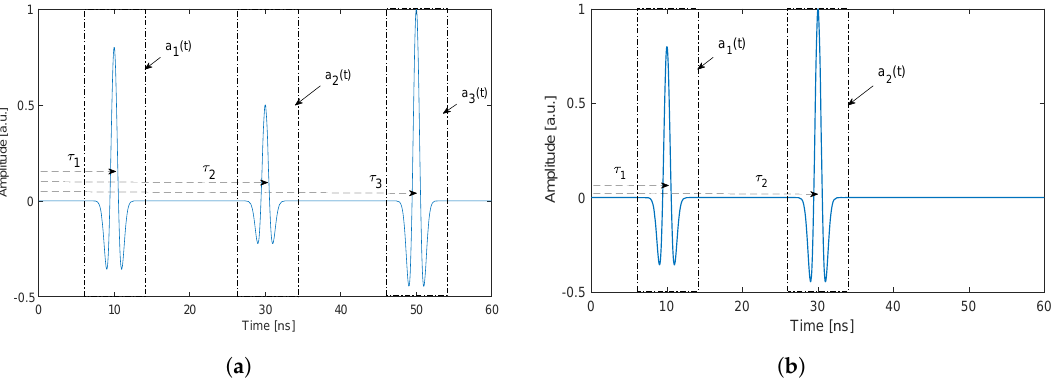
Figure 3. Schematic illustration of a detected time domain signal, with the three reflected waves, a 1 , a 2 , and a 3 , at times τ 1 , τ 2 , and τ 3 . The part illustrates the time windows and stating times used in the analysis. A signal ( a ) with three interfaces, and ( b ) with two interfaces ( D 3 = 0 ) , where the reference object is at the second